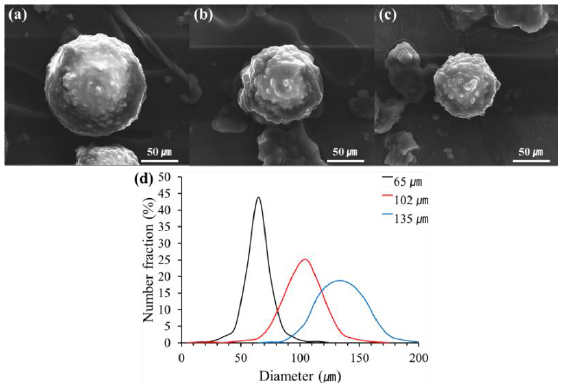
Figure 1. Scanning electron microscope (SEM) images of the linseed-oil-loaded microcapsules formed at agitation rates of ( a ) 1000 rpm, ( b ) 1500 rpm and ( c ) 2000 rpm. ( d ) Size distribution of the microcapsules according to agitation